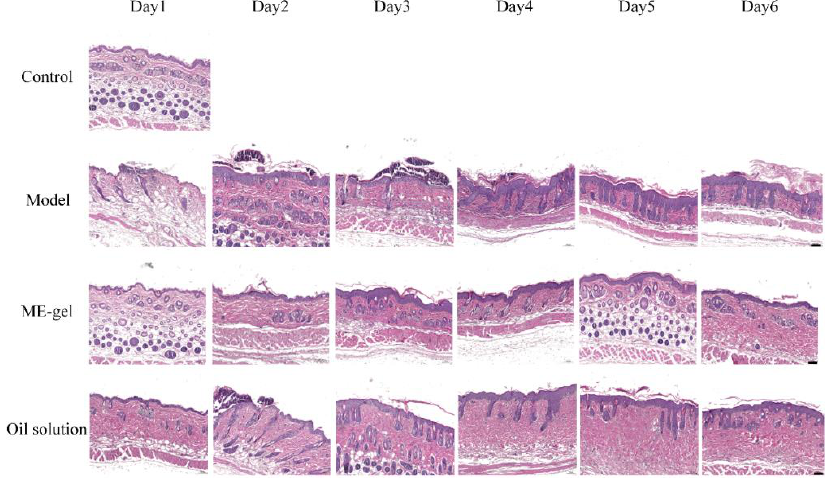
Figure 8. Effect of IR on skin cytokines in psoriatic mice (magnification 100×; scale bar 100 µm).